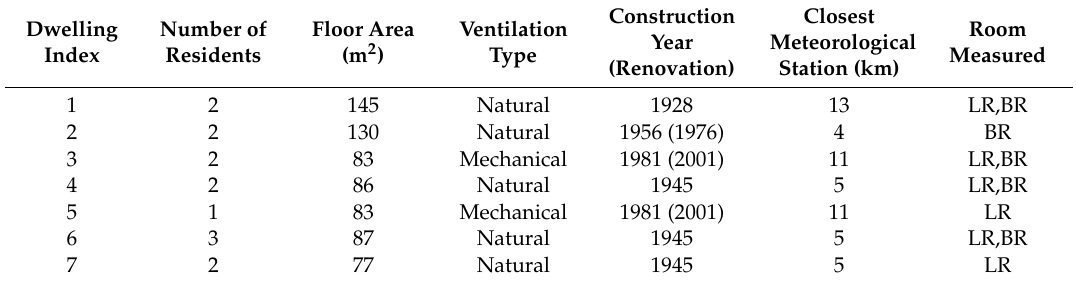
Table 1. Characteristics of the dwellings investigated related. LR: living room, BR: bed room.